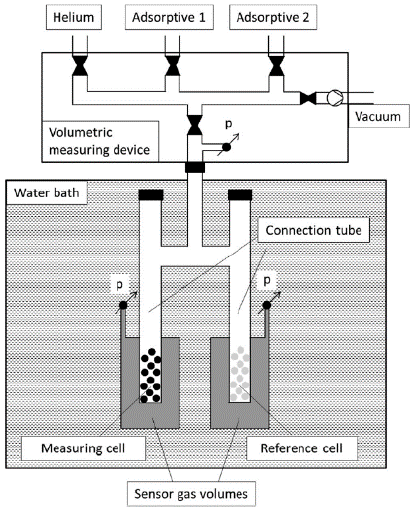
Figure 5. Schematic view of experimental setup [57]. With the volumetric measuring instrument, pure compound isotherms can be mea- sured between a high vacuum (<10 − 7 Pa) and ambient conditions (101.3 kPa). For